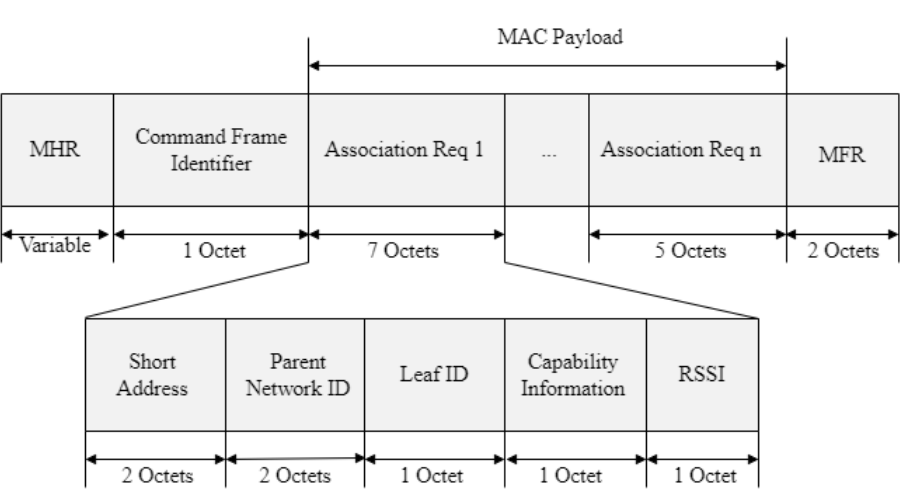
Figure 9. Format of the proposed association-relay frame.